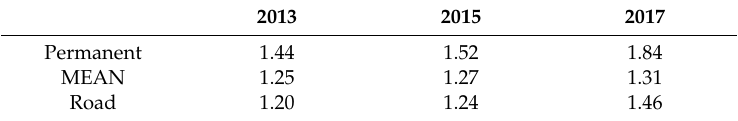
Table 6. The VIF values for the ordinary least squares (OLS) regression models.